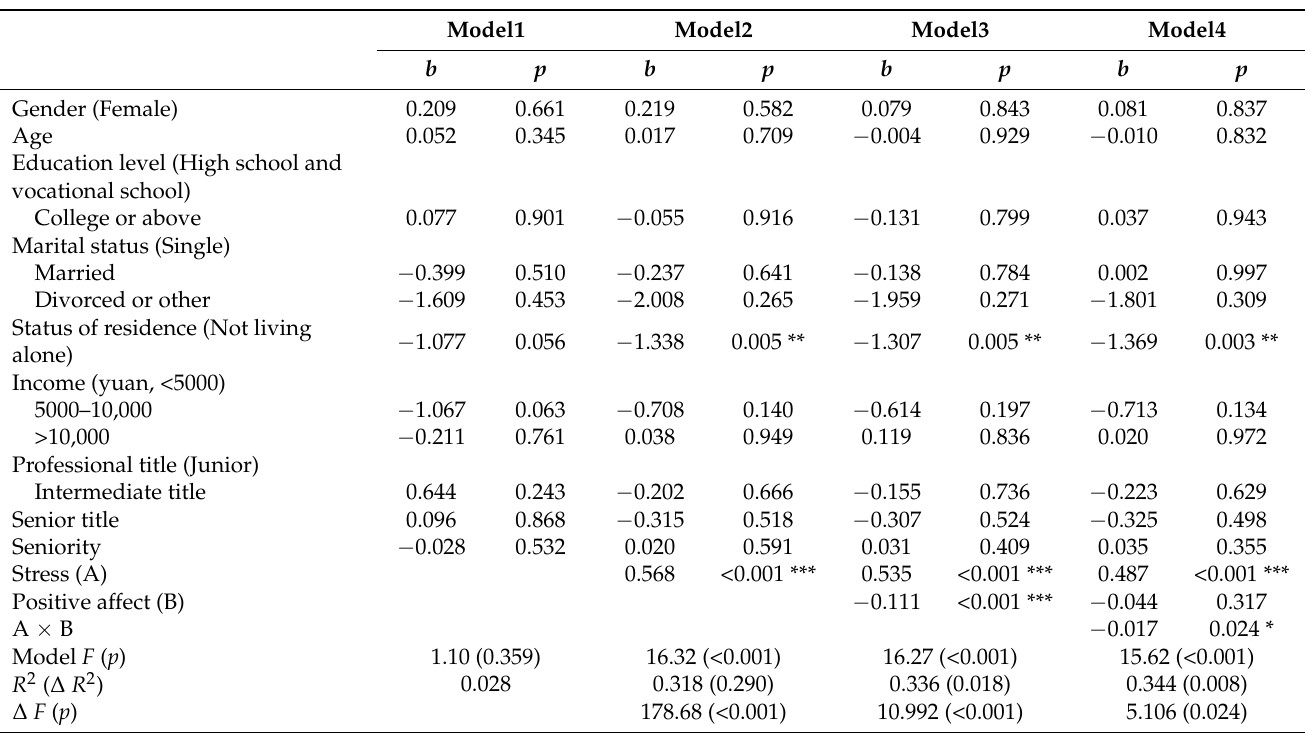
Table 5. Moderating effect of positive affect on the relationship between stress and depression in the high-stress